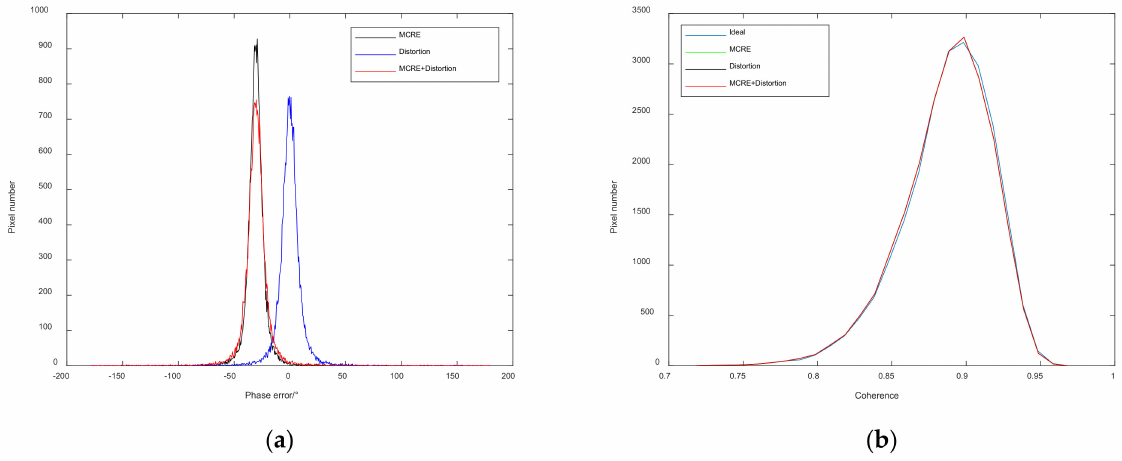
Figure 10. ( a ) Histogram of PolInSAR phase error. ( b ) Histogram of PolInSAR coherence.